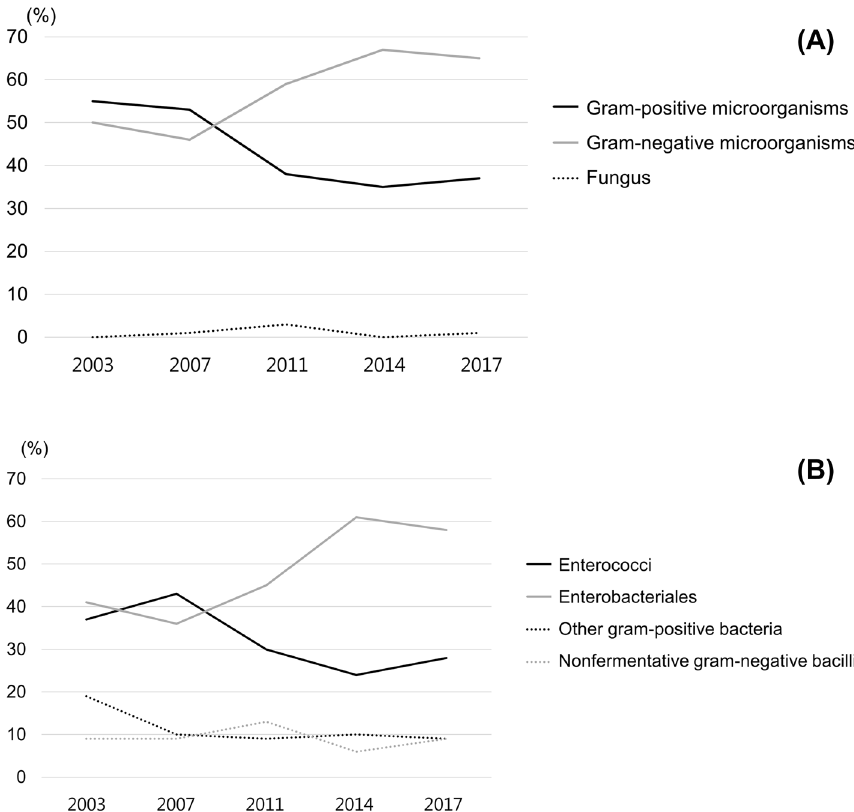
Figure 1. Trends in the frequencies of microorganisms isolated from the bile of gallbladder in acute cholecystitis patients between January 2003 and December 2017. ( A ) A significant decreasing trend in frequency was observed for gram-positive microorganisms ( P = 0.016), whereas gram-negative microorganisms ( P = 0.010) showed a significant increasing trend during the investigated period. There was no significant change in the frequency of fungal infections over time ( P = 0.521). ( B ) Among the gram-positive microorganisms, the frequency of infections caused by enterococci ( P = 0.041) significant declined over time, while there were no significant trends associated with infections caused by other types of gram-positive bacteria ( P = 0.404). Among the gram-negative microorganisms, the frequency of infections caused by species from the order Enterobacteriales significantly increased over time ( P = 0.005), but there was no significant trend associated with infections caused by non-fermentative bacilli ( P =